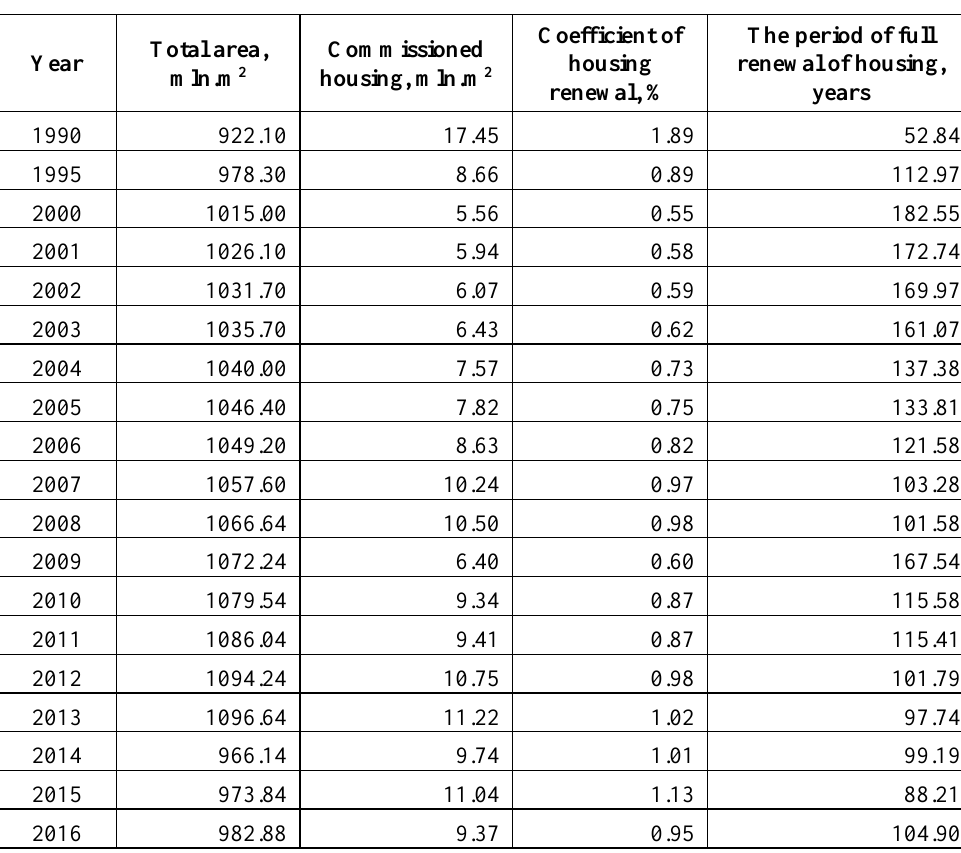
Table 1. Coefficient of housing renewal,